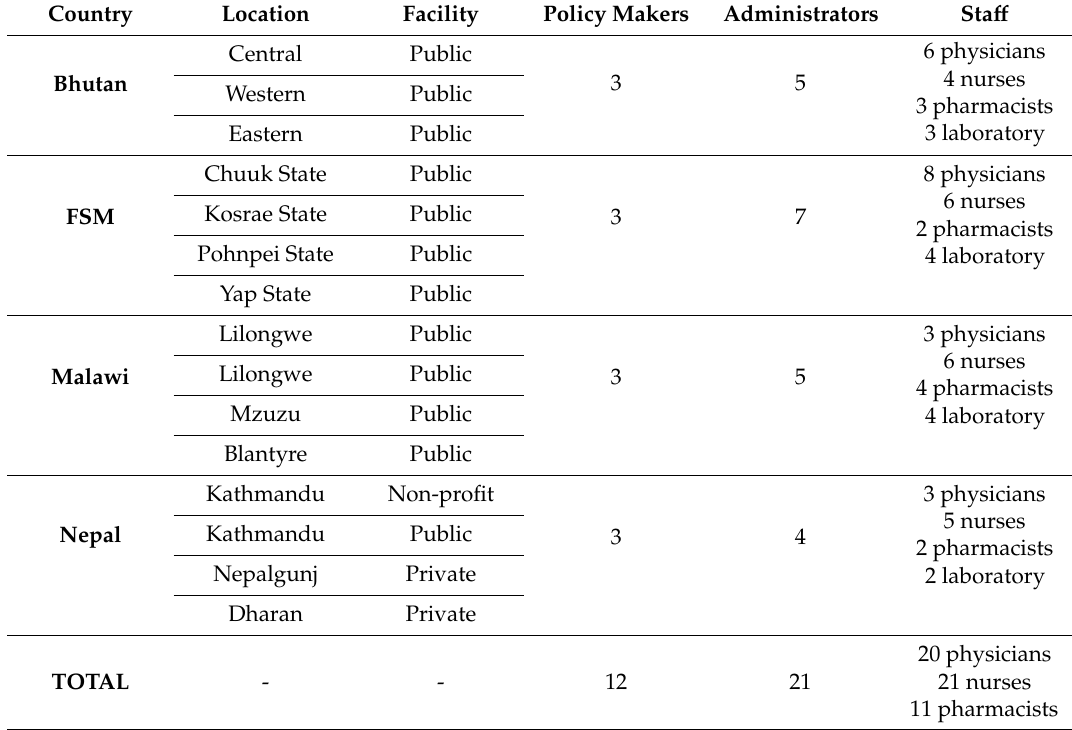
Table 5. Study sites, health care facility types, and sample sizes for policy makers, facility administrators, and clinical sta ff